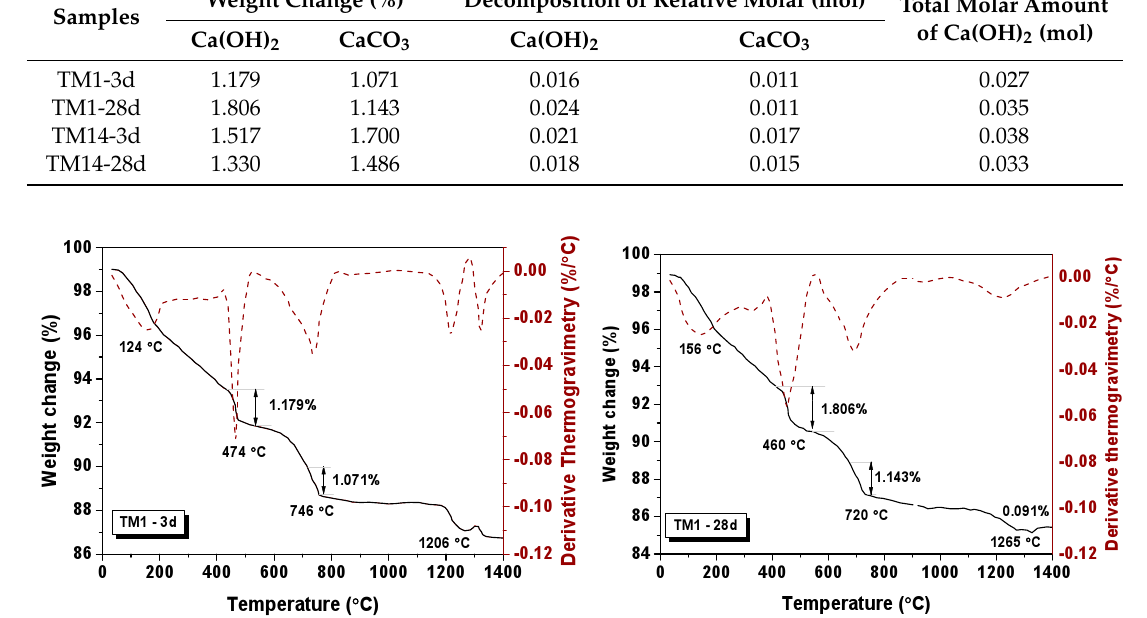
Table 10. Decomposition rate (%) of different reaction products.